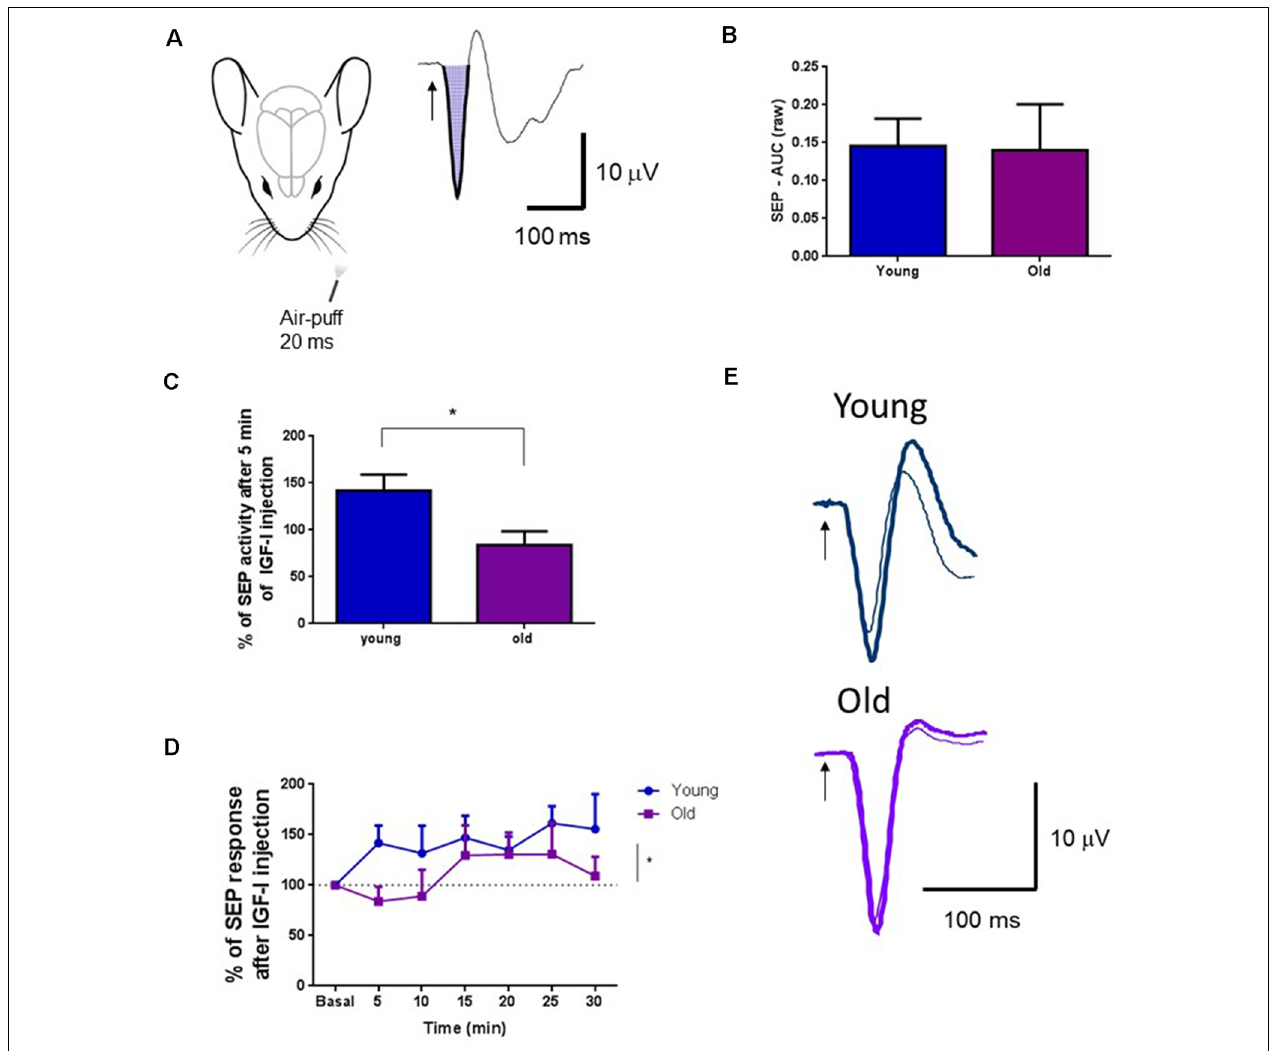
FIGURE 5 | IGF-I facilitated tactile S1 cortical responses. (A) Representative diagram of mouse head and air-puff stimulation of whiskers (20 ms duration; left). A representative somatosensory evoked potential (SEP) in the S1 cortex and the calculated area under the curve is shown on the right. (B) Plot of the mean area under the curve for young and old mice in basal conditions. There were no differences between young and old mice (young = 14; 0.1520 ± 0.0379 mV 2 ; old = 13; 0.1402 ± 0.060 mV 2 ; p = 0.8682, Unpaired t -test). The mean area in basal condition was considered as 100%. (C) The SEP area increased in young mice after local injection of IGF-I in the HDB nucleus (10 nM; 0.2 µ l) at 5 min after injection while the SEP area was not affected in old mice. Differences between young and old animals were statistically significant (young = 15; 141.9 ± 17.06 µ V 2 ; old = 13; 83.92 ± 14.71 µ V 2 ; * p = 0.0176, Unpaired t -test). (D) Time course of the changes induced by IGF-I local injection in the SEP area. Through time, the IGF-I facilitation was significantly different between groups (young = 15, old = 13; F (1,177) = 5.886, p = 0.0163; Ordinary Two-way ANOVA). (E) Representative SEP in young and old mice, at basal and 5 min after IGF-I injection. Thin traces, basal condition; thick traces, 5 min after